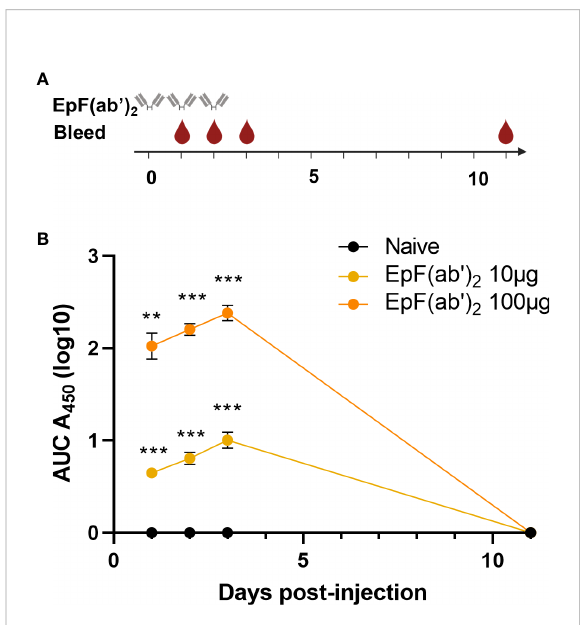
FIGURE 2 Kinetics of EpF(ab ’ ) 2 in serum after passive immunization in C57BL/6J. (A) Graphical representation of the timeline for EpF (ab ’ ) 2 administration and bleeding. The timeline represents days. (B) AUC representation of EpF(ab ’ ) 2 ELISA detection in the serum at days 1, 2, 3, and 11 in C57BL/6J mice passively immunized with 10 or 100 m g of EpF(ab ’ ) 2 . Statistical analyses were performed as one-sample t -tests compared to the naïve animals (** p <0.01; *** p